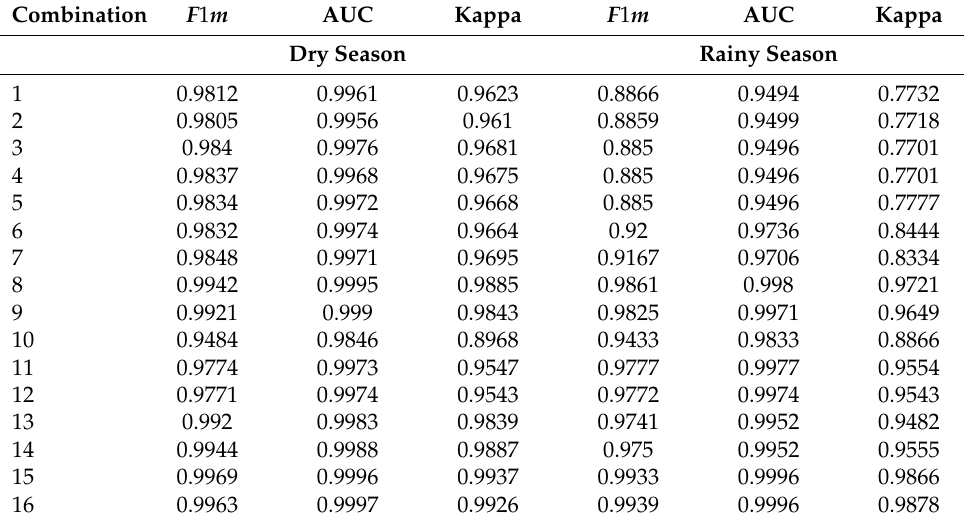
Table 5. Performance indicators obtained using the RF algorithm for all combinations in the dry and rainy seasons.